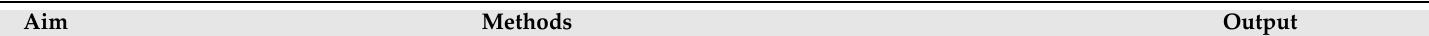
Table 2. Steps to develop the ToC